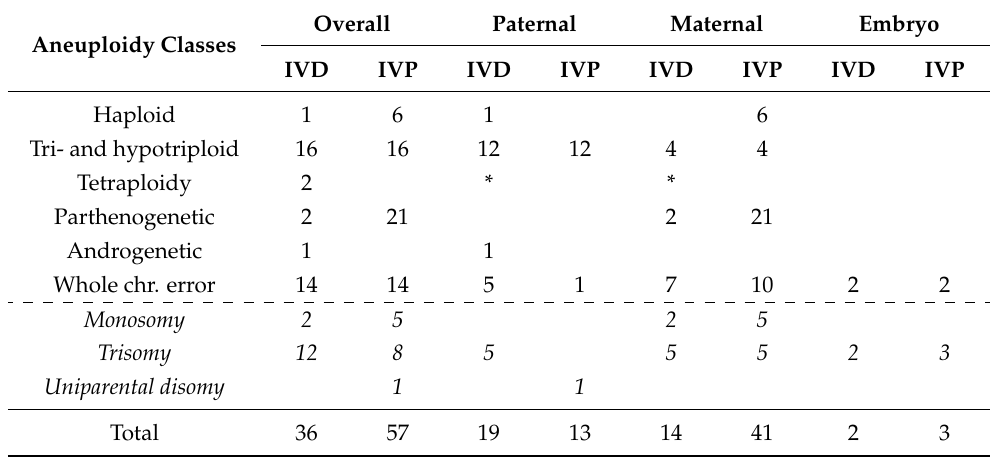
Table 3. Frequency of chromosomal errors by aneuploidy class and their origin (paternal, maternal, or embryo) for in vivo-derived (IVD) and in vitro-produced (IVP) embryos as identified by PGT-A. Aneuploidy Classes